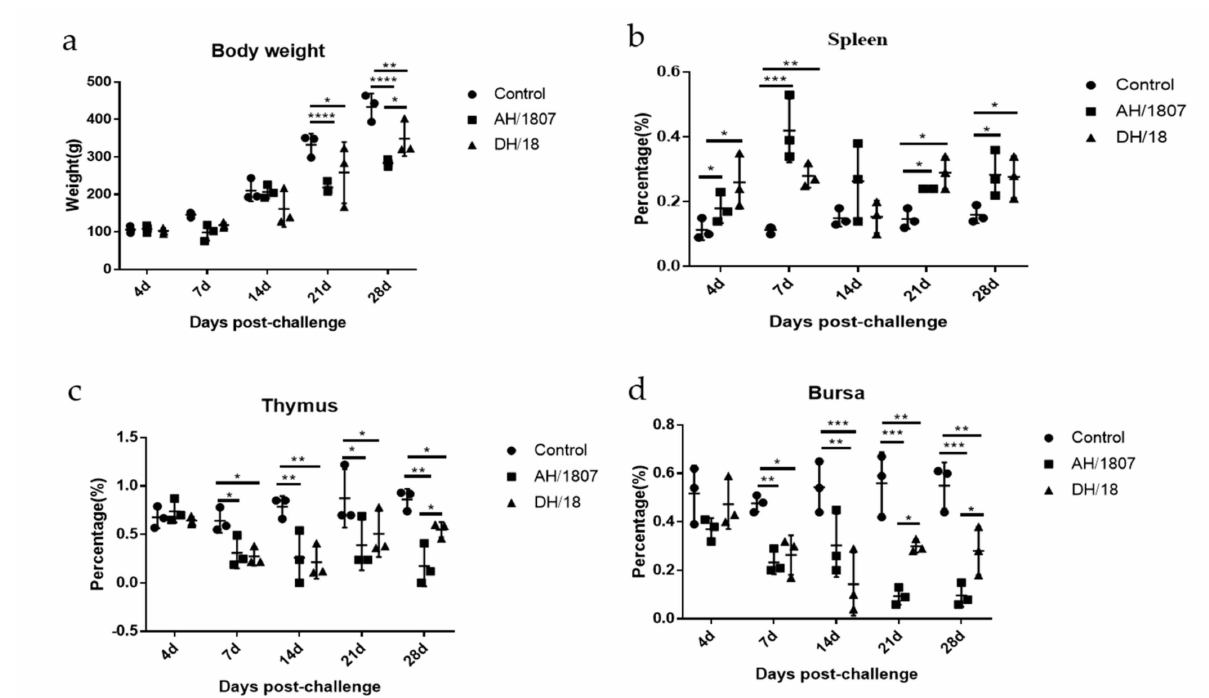
Figure 4. Ratios of immune organ weight to body weight in chickens of each treatment group. The body weights and immune organ indices of MDV strains at 4, 7-, 14-, 21-, and 28-days post challenge were analyzed. ( a ) Body weight of chickens in each group. ( b ) Ratio of spleen weight to body weight in chickens of each group. ( c ) Ratio of thymus weight to body weight in chickens of each group. ( d ) Ratio of bursa weight to body weight in chickens of each group. Two-way ANOVA was performed for significance analysis. The data are shown as mean with standard deviations (SDs). * p < 0.05, ** p < 0.01, *** p < 0.001, **** p <